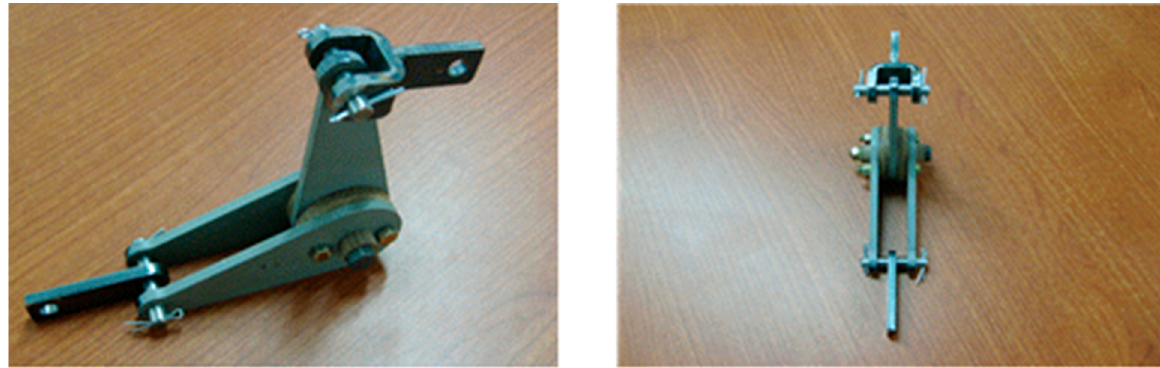
Figure 17. Prototype of reduced-size rotary type damper. The rotary-type damper used in the experiment was smaller than the actual one.